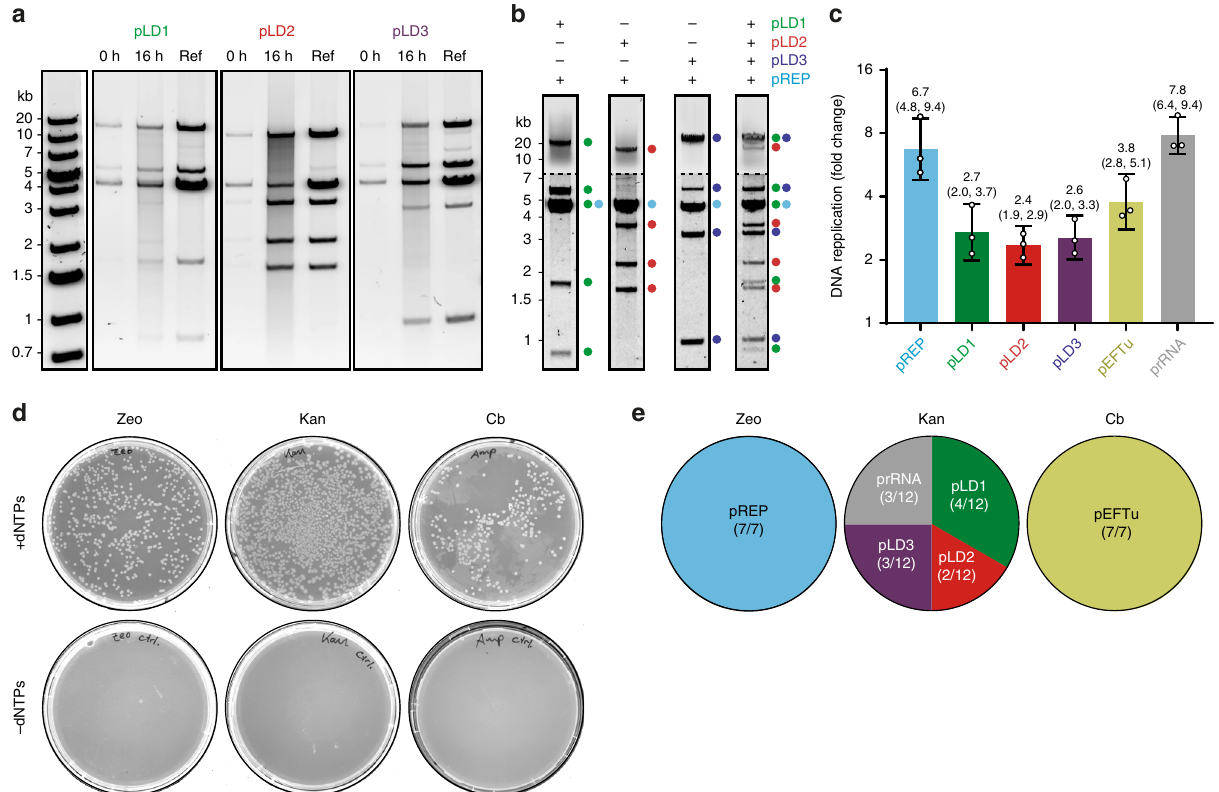
Fig. 2 In vitro replication of large multicistronic DNA constructs. a MluI restriction patterns of gel-puri fi ed TTcDR products from individual pLD/pREP co- replication experiments at t = 0 h and t = 16 h. Concentrations were 6 nM pREP and 0.7 nM pLD1, pLD2 or pLD3. Authentic control standards for clonal pREP/pLD mixtures are shown for each TTcDR reaction. The raw gel image is shown in Supplementary Fig. 3A. Samples were tested in three